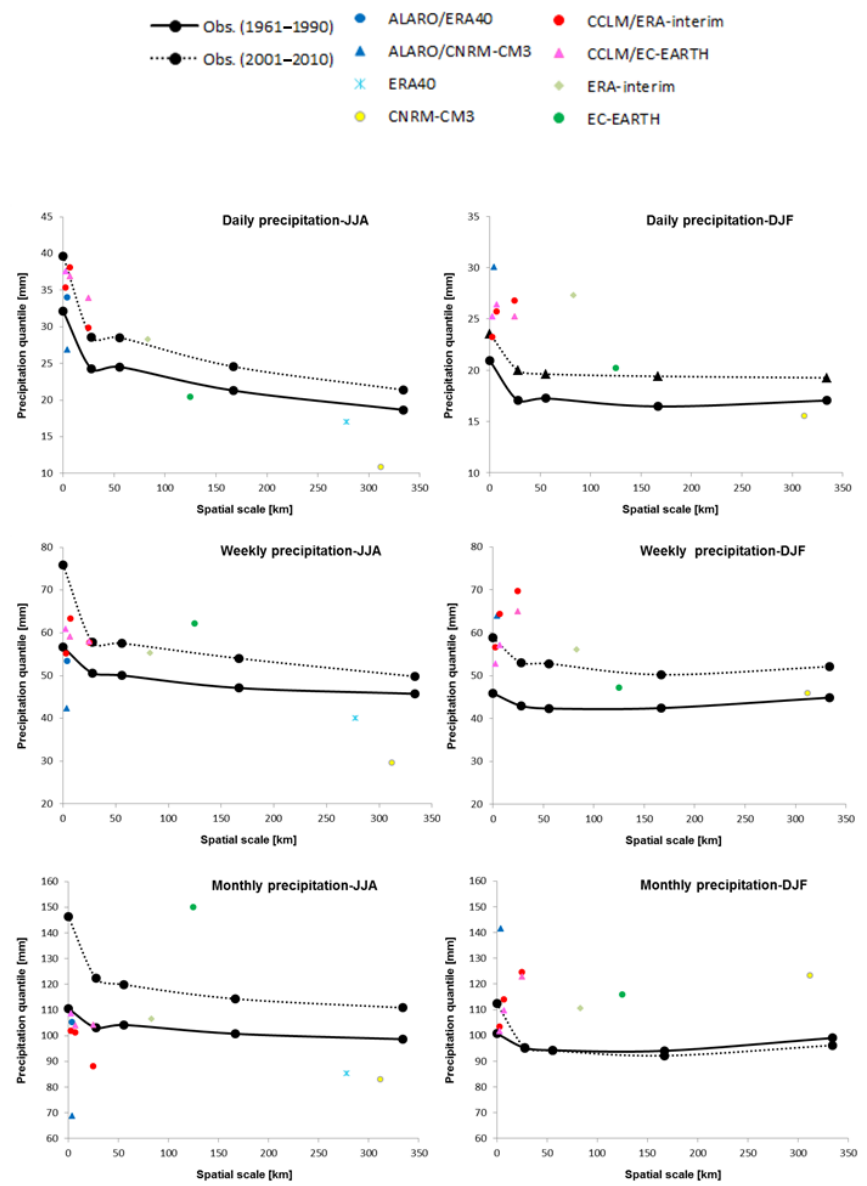
Figure 5. Validation of the extreme precipitation (averaged over the extreme events with T > 1 year) simulations for ALARO, CCLM and the driving GCMs or reanalysis data based on point and pixel interpolated Uccle observations for the summer (left panels) and winter (right panels) seasons, vs. the models’ spatial